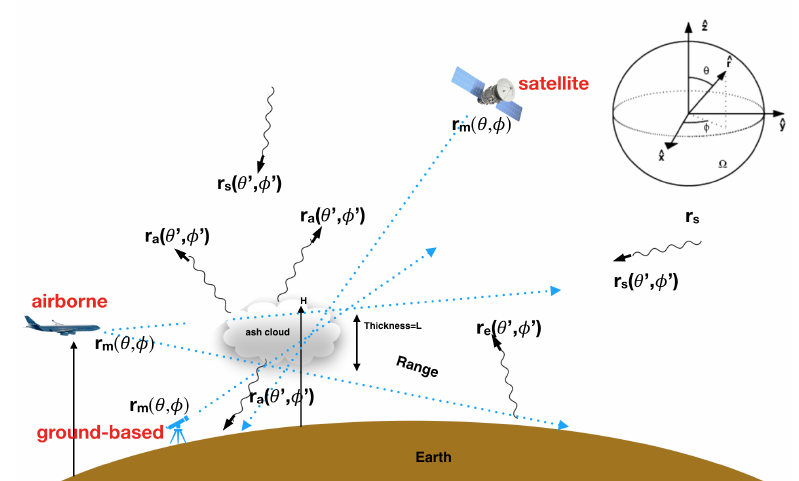
Figure 2. Radiative transfer problem. The inset plot (top-right) shows the definitions of the angles θ and φ